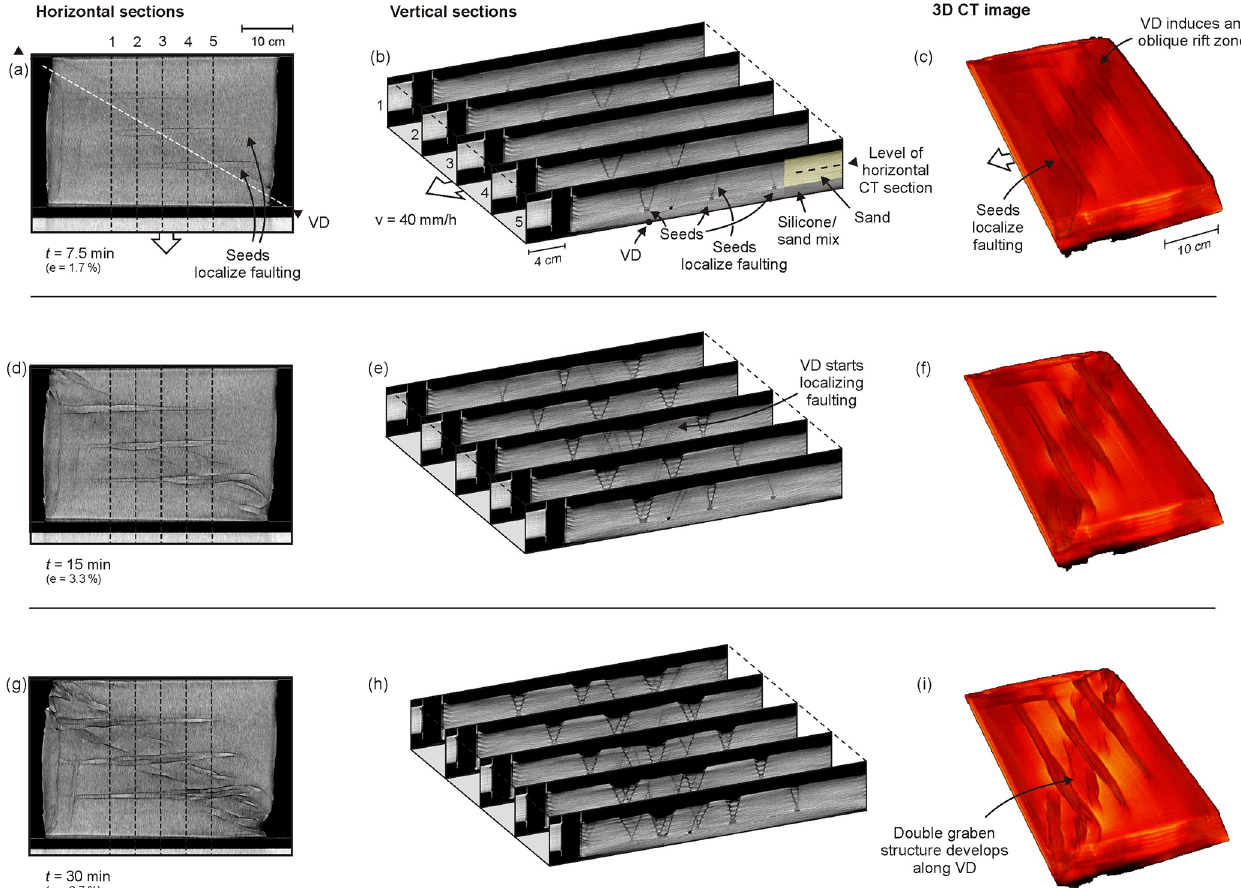
Figure 10. CT analysis of Model O (30 ◦ oblique VD, model axis-parallel seeds, doubled extension velocity, CT-scanned rerun of Model N). (a, d, g) Horizontal sections through the brittle layer. (b, e, h) Serial cross sections. (c, f, i) 3D CT images. Note that the colours in these images represent scanning intensities and are not to be interpreted as a measure of model surface